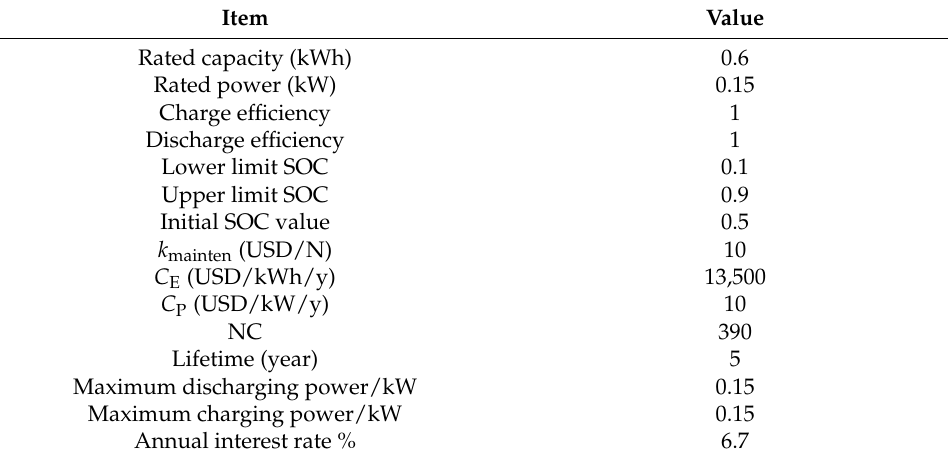
Table 1. Parameters of the battery bank.